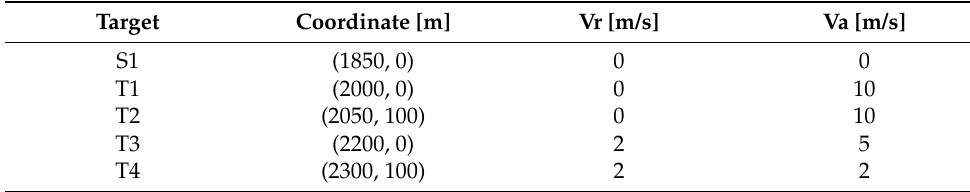
Table 2. Target parameters.